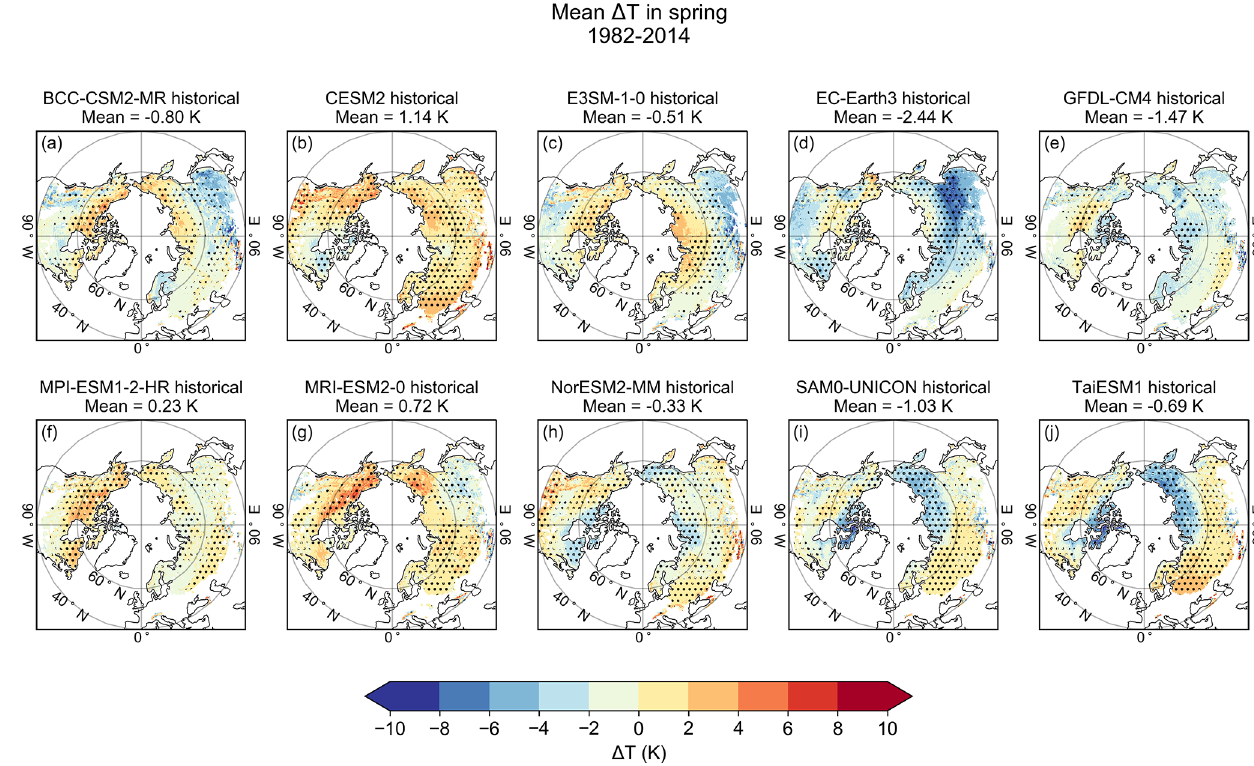
Figure 10. The mean model bias in T ( (cid:49)T , model minus observation) in snow-covered areas in spring 1982–2014. The dots indicate areas with either cold bias and positive SWE bias or warm bias and negative SWE bias, i.e., the areas where T bias could logically explain the SWE bias.